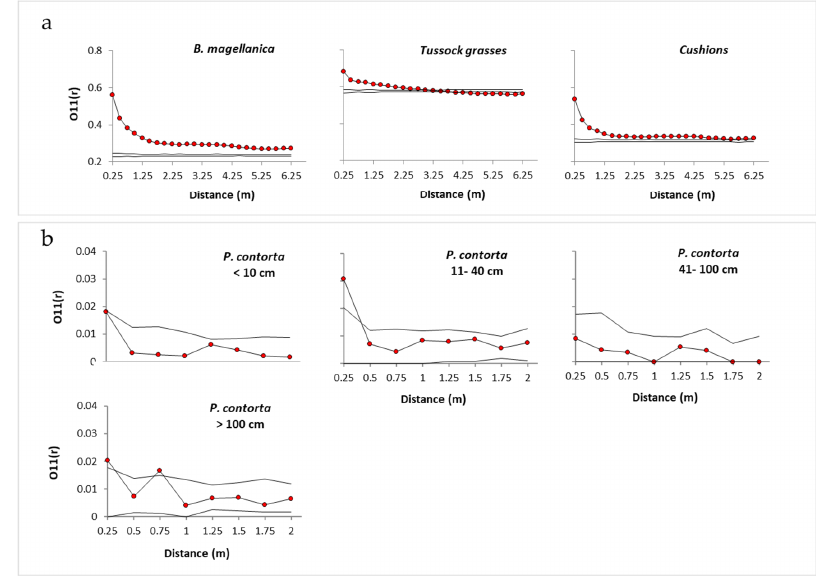
Figure 7. O-ring statistics for the spatial distribution of ( a ) the three substrates: B. magellanica , tussock grasses, cushion plants, and ( b ) each Pinus contorta height class. The O11( r ) estimator indicates the probability of finding a cell of the same category 1 at a distance r (shown in y axis) away from a cell of another cell of category 1. Continuous lines represent confidence envelopes from the 99 Monte Carlo simulations. If the O-ring function (red dots) exceeds the upper confidence level, it indicates an aggregated pattern of the species or plants involved. If the function locates below the lower confidence interval, then it indicates a repulsion or regularly spatiated distribution of the plants. If the function is located between both confidence intervals, then the distribution of the plants does not differ from the Complete Spatial Randomness (CSR) pattern. Forests 2019 , 10 , x FOR PEER REVIEW